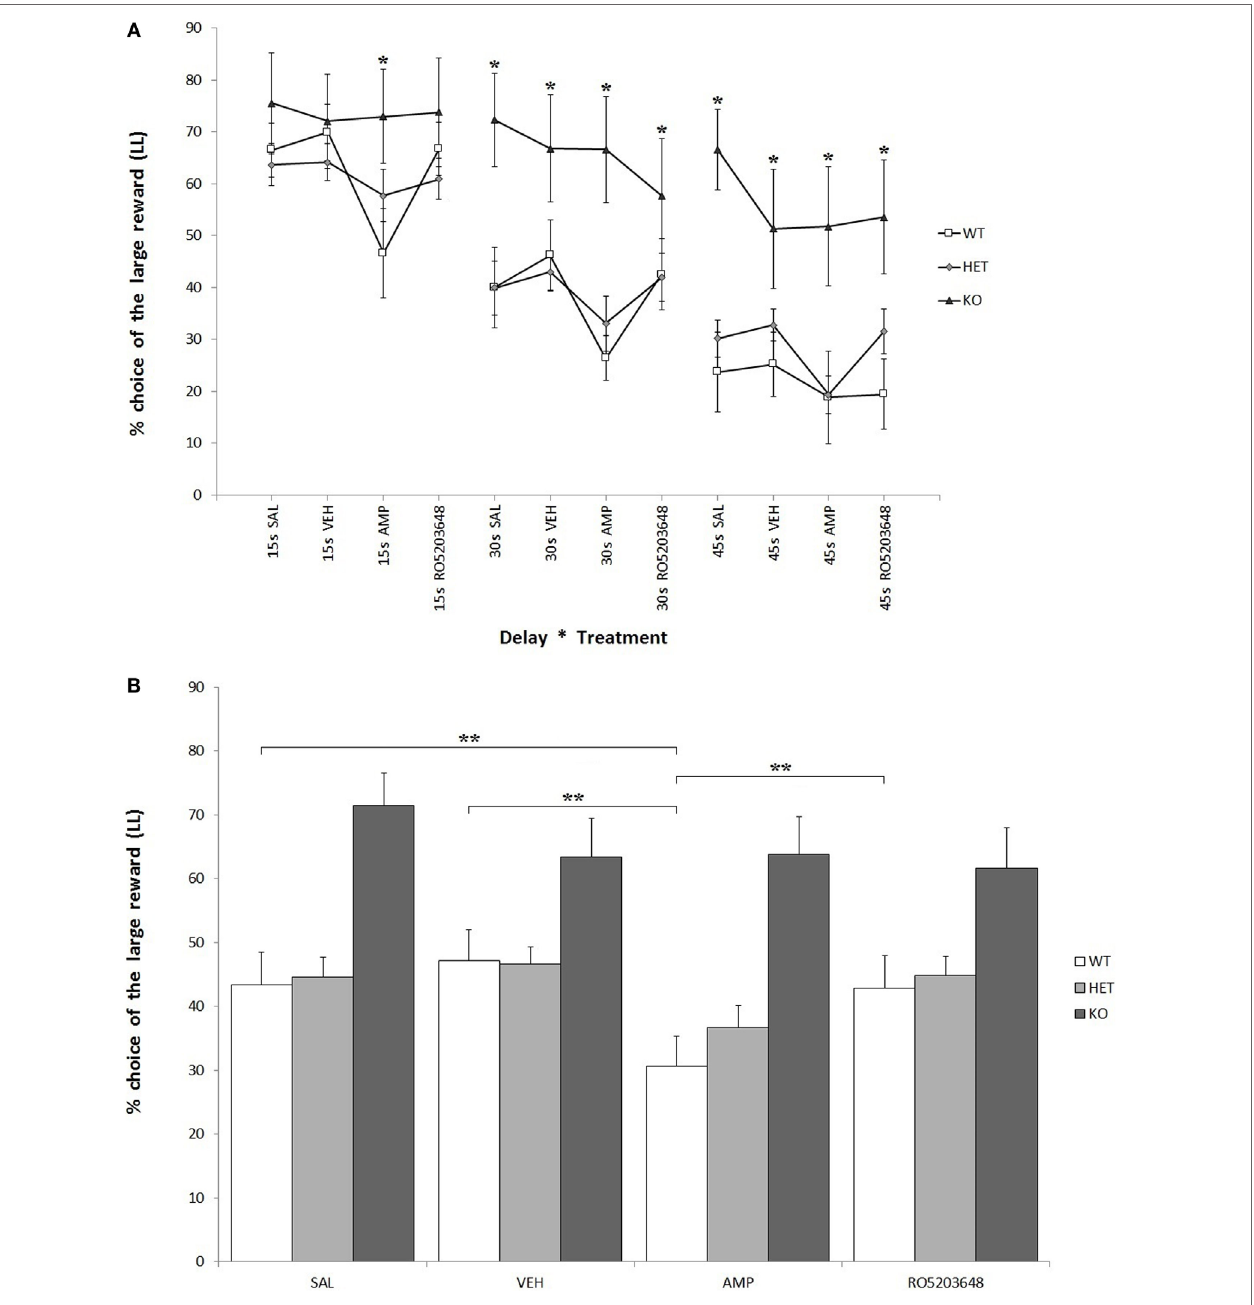
FigUre 3 | Percentage preference for a large-and-late (LL) reward over a small-and-soon (SS) one in an operant Intolerance-to-Delay Task. (a) Preference for LL at increasing delays after the administration of different drugs. Whereas preference for LL decreases significantly at higher delays, knockout (KO) rats show a significantly higher preference for LL when compared to both wild-type (WT) and dopamine transporter–heterozygous (HET) rats. Amphetamine (AMPH) reduces significantly LL preference in WT rats at all three delays. * P < 0.05. (B) The effect of the different drugs on LL preference (average value collapsed across delays). WT rats, after AMPH administration, show a significantly reduced LL preference compared to the saline, vehicle, and RO-5203648 groups. ** P <